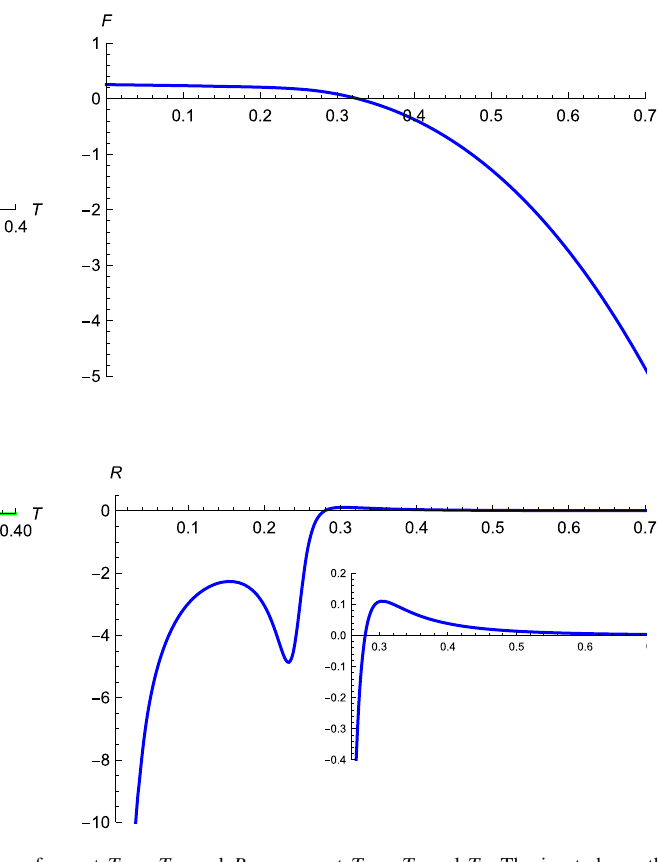
at T = T p , and R = −∞ at T = T 1 and T 2 . The inset shows that R > 0 for the Large BH solution at a high enough temperature. Right Column: Q = 0 . 25 > Q c . There is only one black hole solution. The inset shows that R > 0 when the temperature is high enough